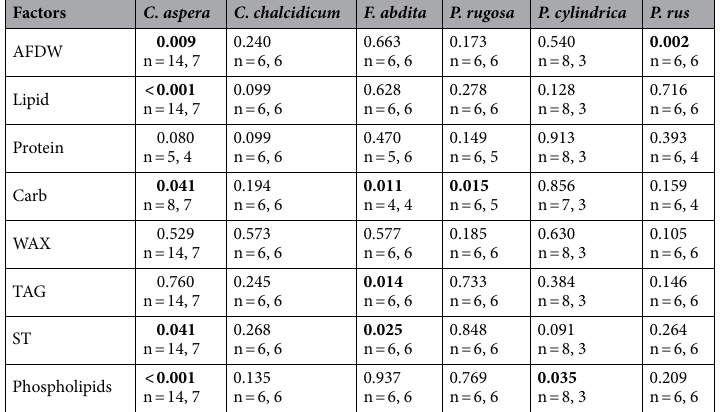
Table 2. Welch’s t-test p-values of energy reserves and intraspecific lipid class differences across sites, except for AFDW of C. chalcidicum and carbohydrate of C. aspera where a non-parametric Mann–Whitney–